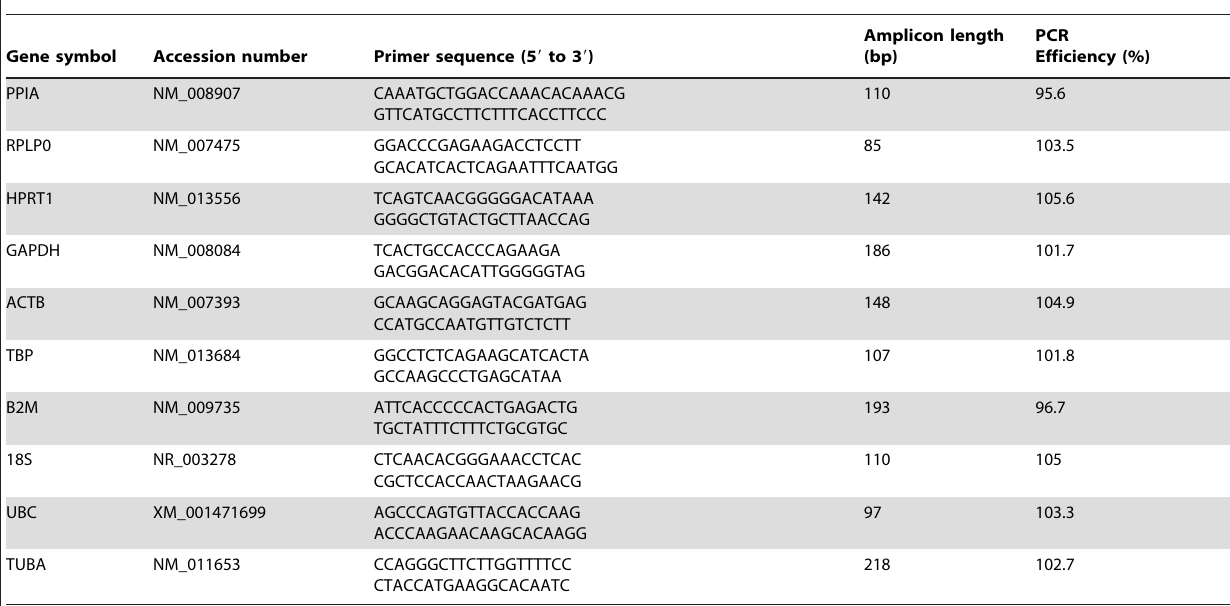
Table 2. Primer information for qRT-PCR